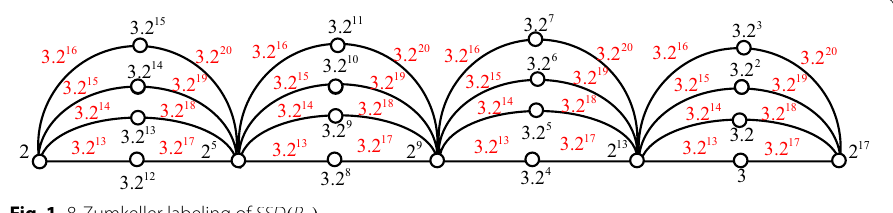
Fig. 1 8-Zumkeller labeling of SSD ( P 5